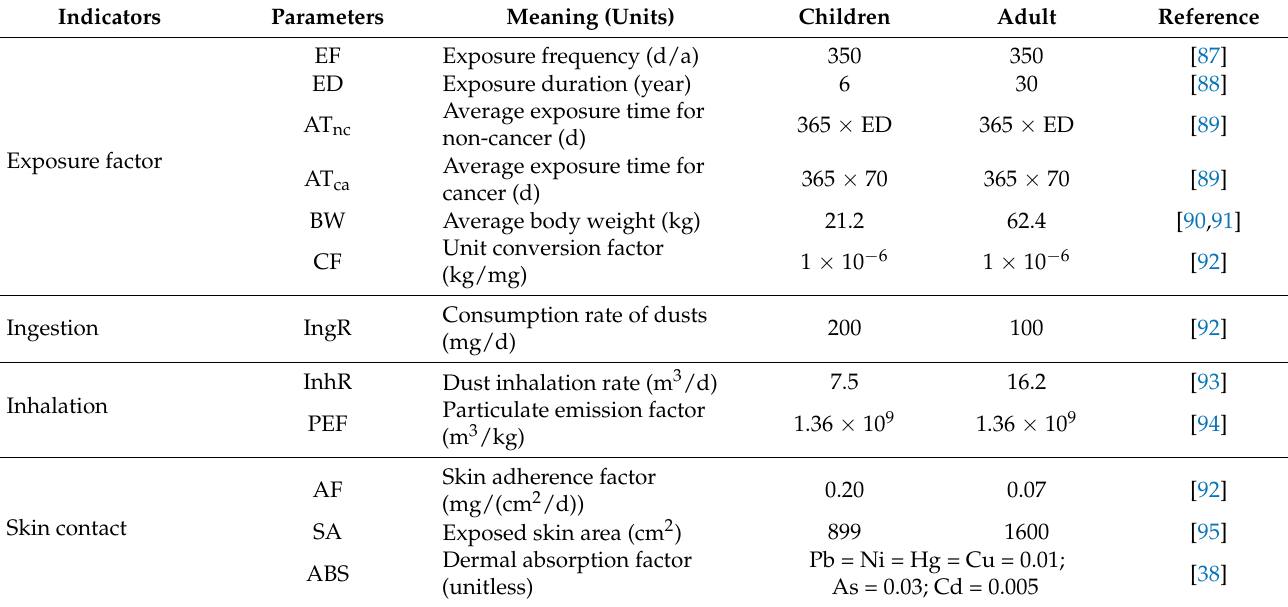
Table 1. The exposure parameters are used to estimate chronic daily